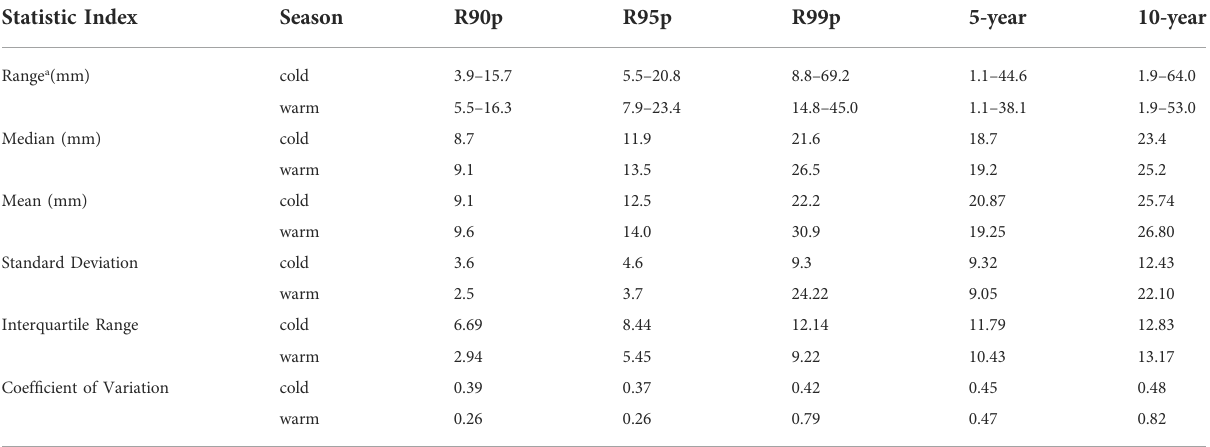
TABLE 1 Statistic of multi-stations extreme